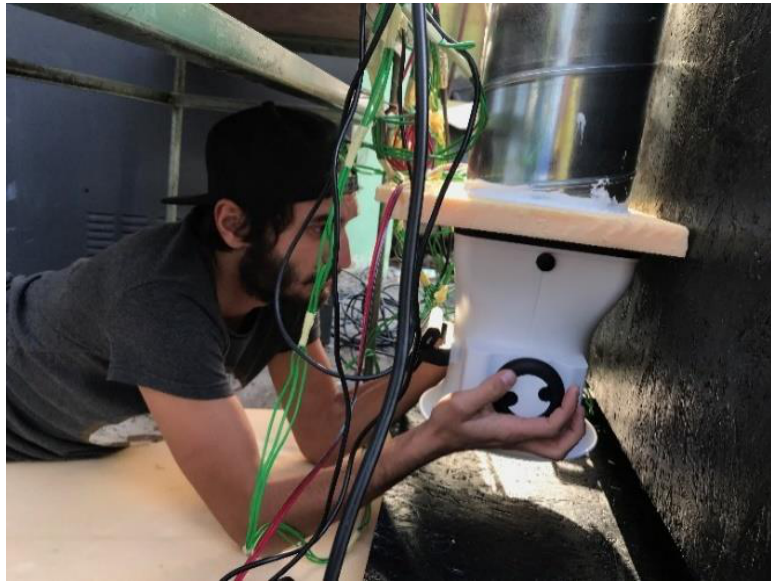
Figure 3. Flow meter installation within the experimental set-up.